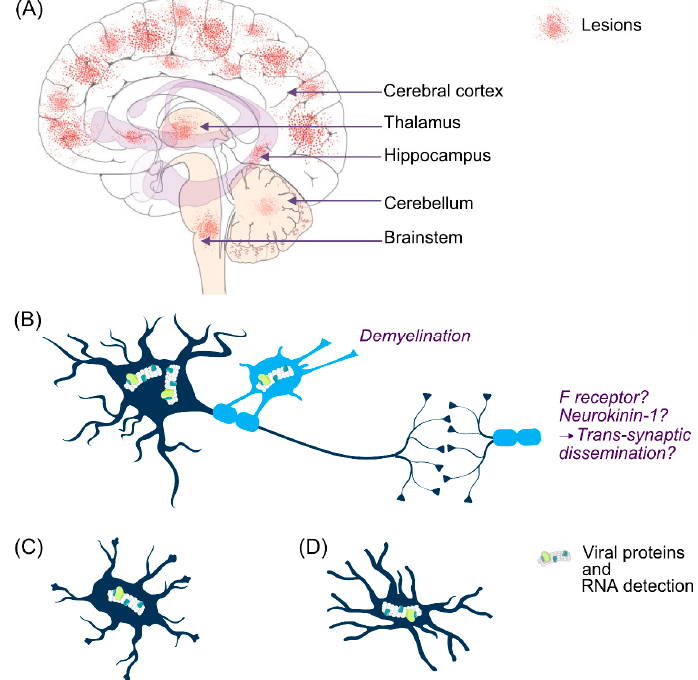
Figure 4. MeV central nervous system infection. Lesion areas are found in the brain of SSPE and MIBE patients but the specific areas associated with RNA detection are still poorly documented ( A ). Generally, MeV infects neurons and oligodendrocytes in humans ( B ). Occasionally, MeV RNA is also found in astrocytes ( C ) and microglia ( D